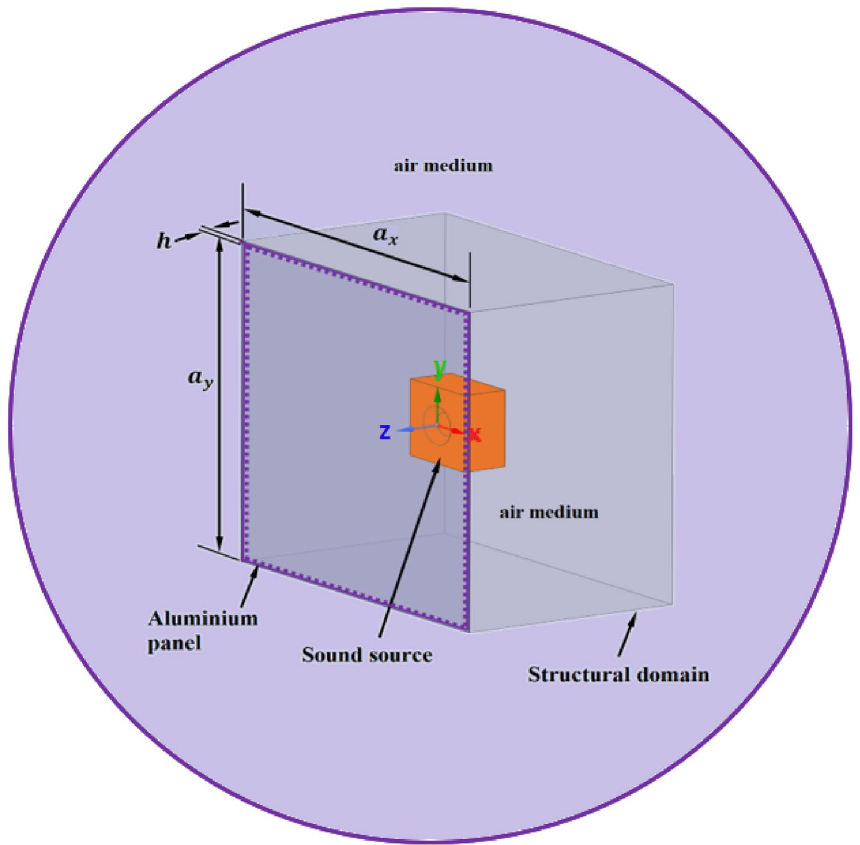
Figure 1. Schematic representation of the vibro-acoustic problem for the present study.